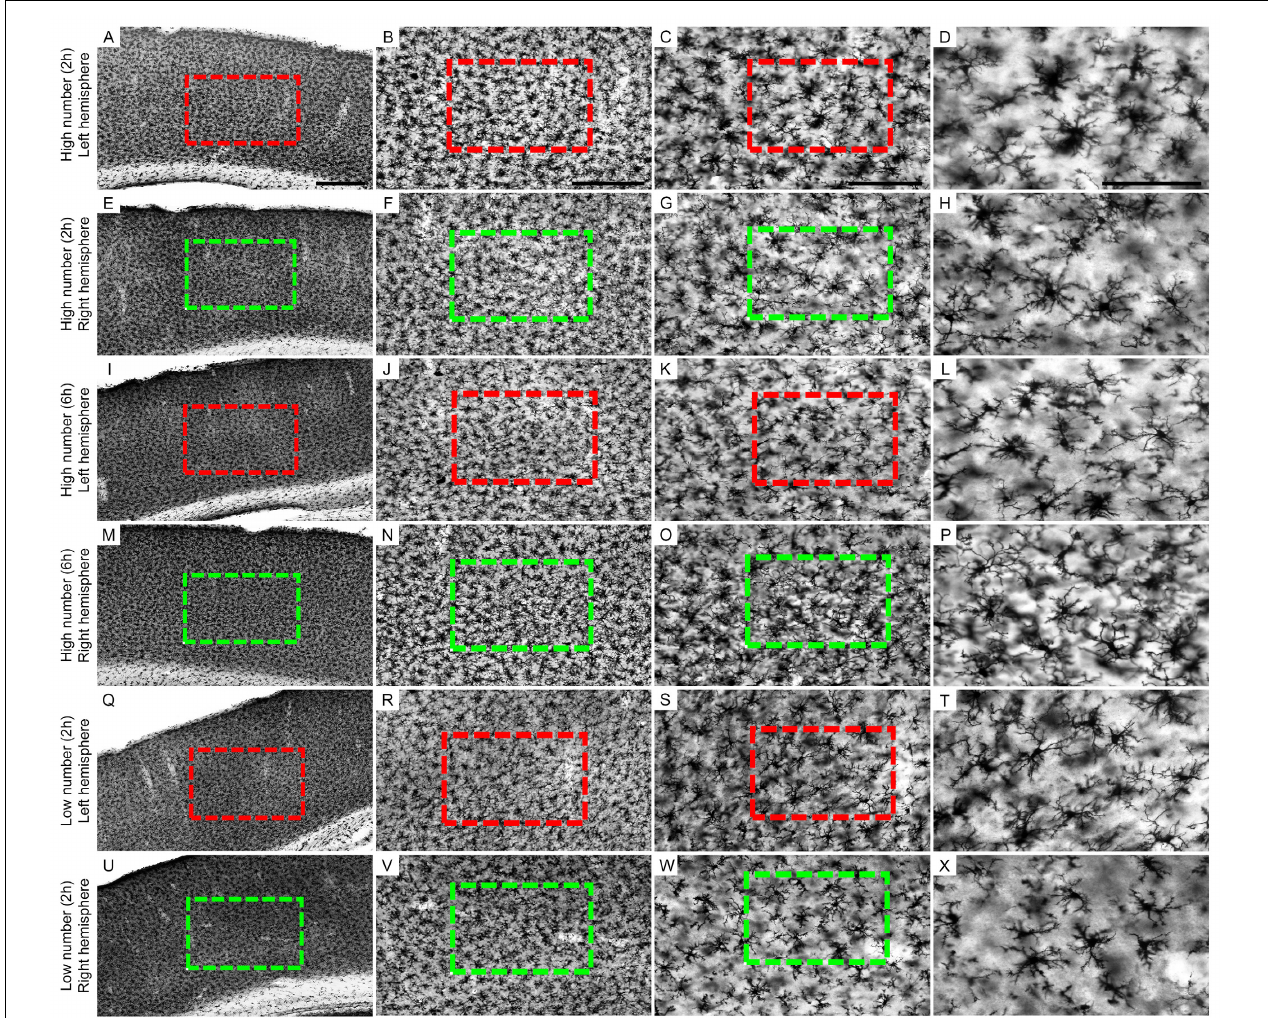
FIGURE 8 | Low-power and high-power photomicrographs of the somatosensorial (ss) cortical layers in the indicated 6 and 2 h recording groups. The sections that were immunolabeled with anti-Iba-1 antibody showed qualitative differences between the 6 and 2 h recording groups: high number of CSD episodes (2-h recording) in the left/ipsilateral hemisphere (A–D) ; high number of CSD episodes (2-h recording) in the right/contralateral hemisphere (E–H) ; high number of CSD episodes (6-h recording) in the left/ipsilateral hemisphere (I–L); high number of CSD episodes (6-h recording) in the right/contralateral hemisphere (M-P); low number of CSD episodes (2-h recording) in the left/ipsilateral hemisphere (Q–T) ; low number of CSD episodes (2-h recording) in the right/contralateral hemisphere (U–X) . Scale bars in panels (A,E,I,M,Q,U) = 500 µ m; in panels (B,F,J,N,R,V) = 300 µ m; in panels (C,G,K,O,S,W) = 150 µ m; and in panels (D,H,L,P,T,X) = 100 µ